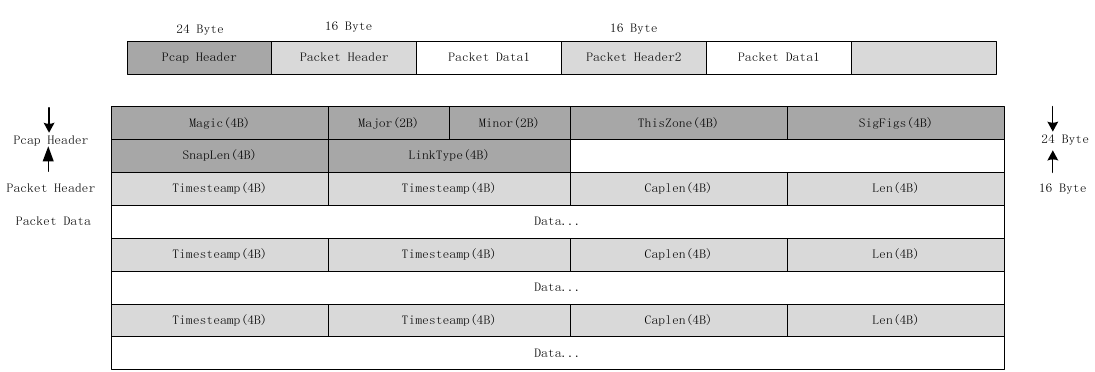
Figure 1. File format of pcap.